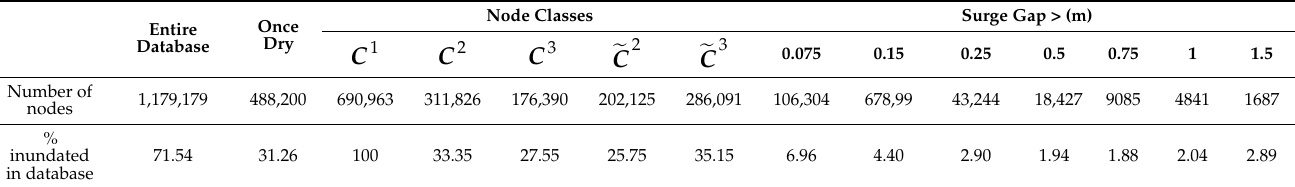
Table 2. Properties of nodes across groups with different